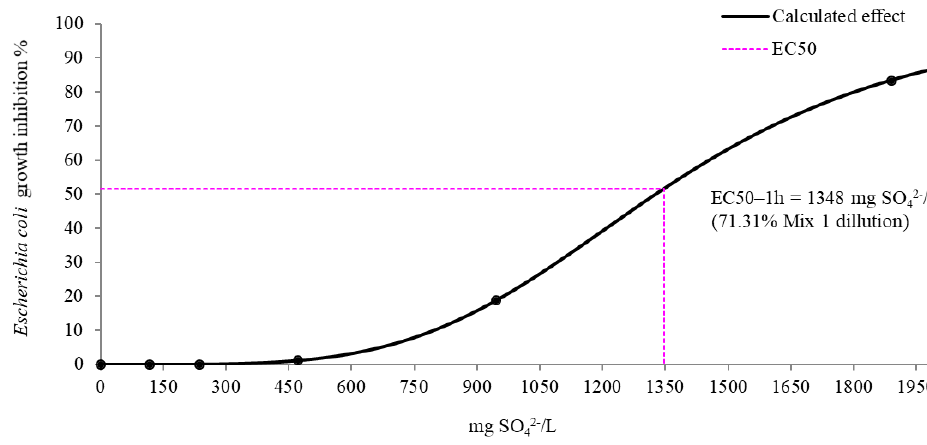
Figure 3. Estimation of EC50 after 1 h incubation of Escherichia coli in the presence of Mix 1. Considering the initial concentration of 1890 mg SO 42 − /L detected for Mix 1 and EC50 after 1h of incubation, we assume that a concentration of 1348 mg SO 42 − /L can induce a growth inhibition of the Escherichia coli population (Figure 3).